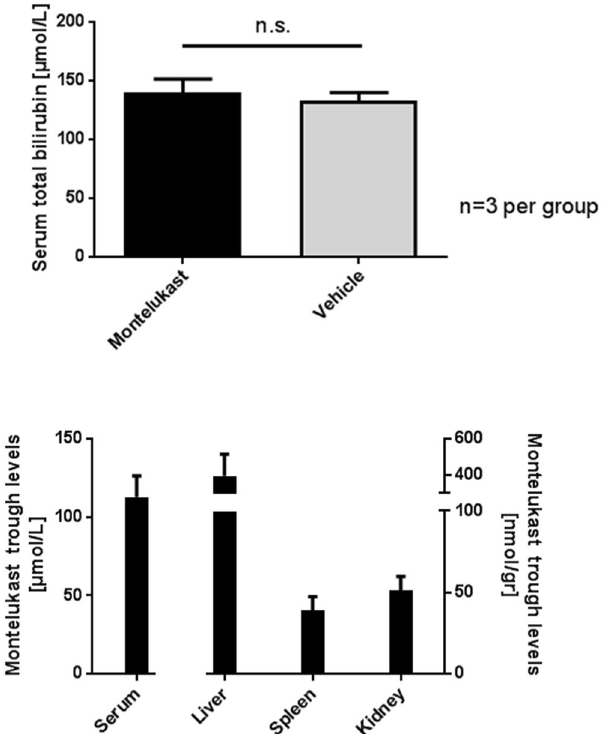
Data represent the mean ± SD of three animals per group. ( B ) Concentration of Montelukast in serum, liver, spleen and kidney of 4 weeks old male Gunn rats after bi-daily intraperitoneal injection of 150 mg/kg Montelukast for 2, 5 days (5 injections). Animals were sacrificed 5 hours after last Montelukast administration. Tissue homogenates were made in 100 mmol/L Tris-HCL pH 7, 8 buffer and concentration of Montelukast was measured by HPLC.